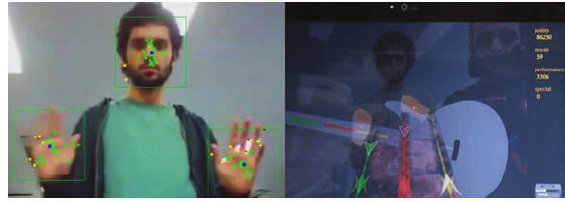
Figure 6. By tracking user hands the reality is augmented showing a virtual guitar to be played. The hand movements of the player are interpreted and